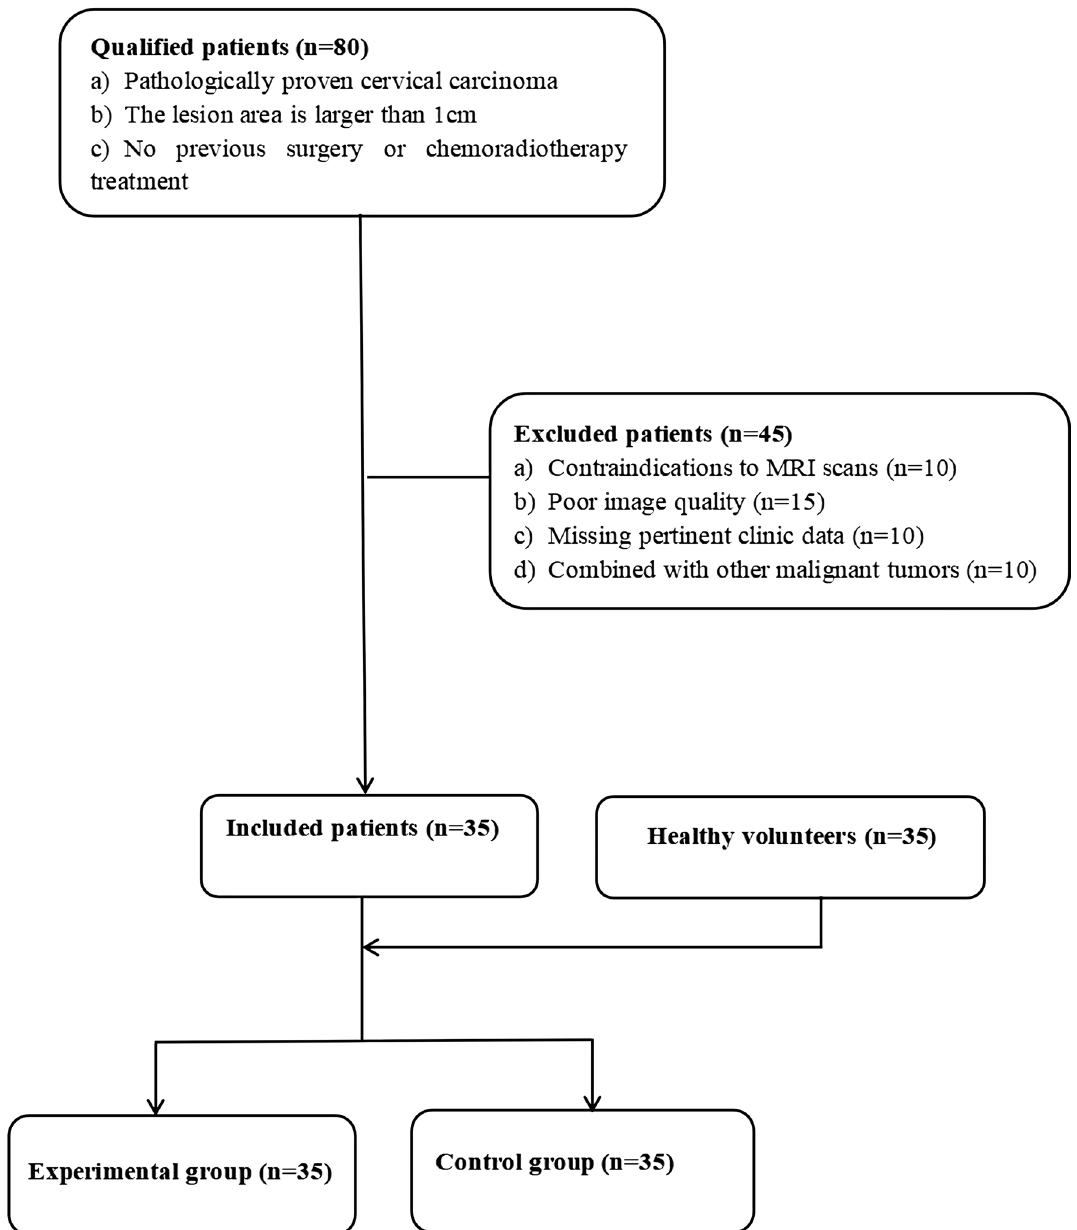
Fig. 1 Workflow of subject inclusion and exclusion in this